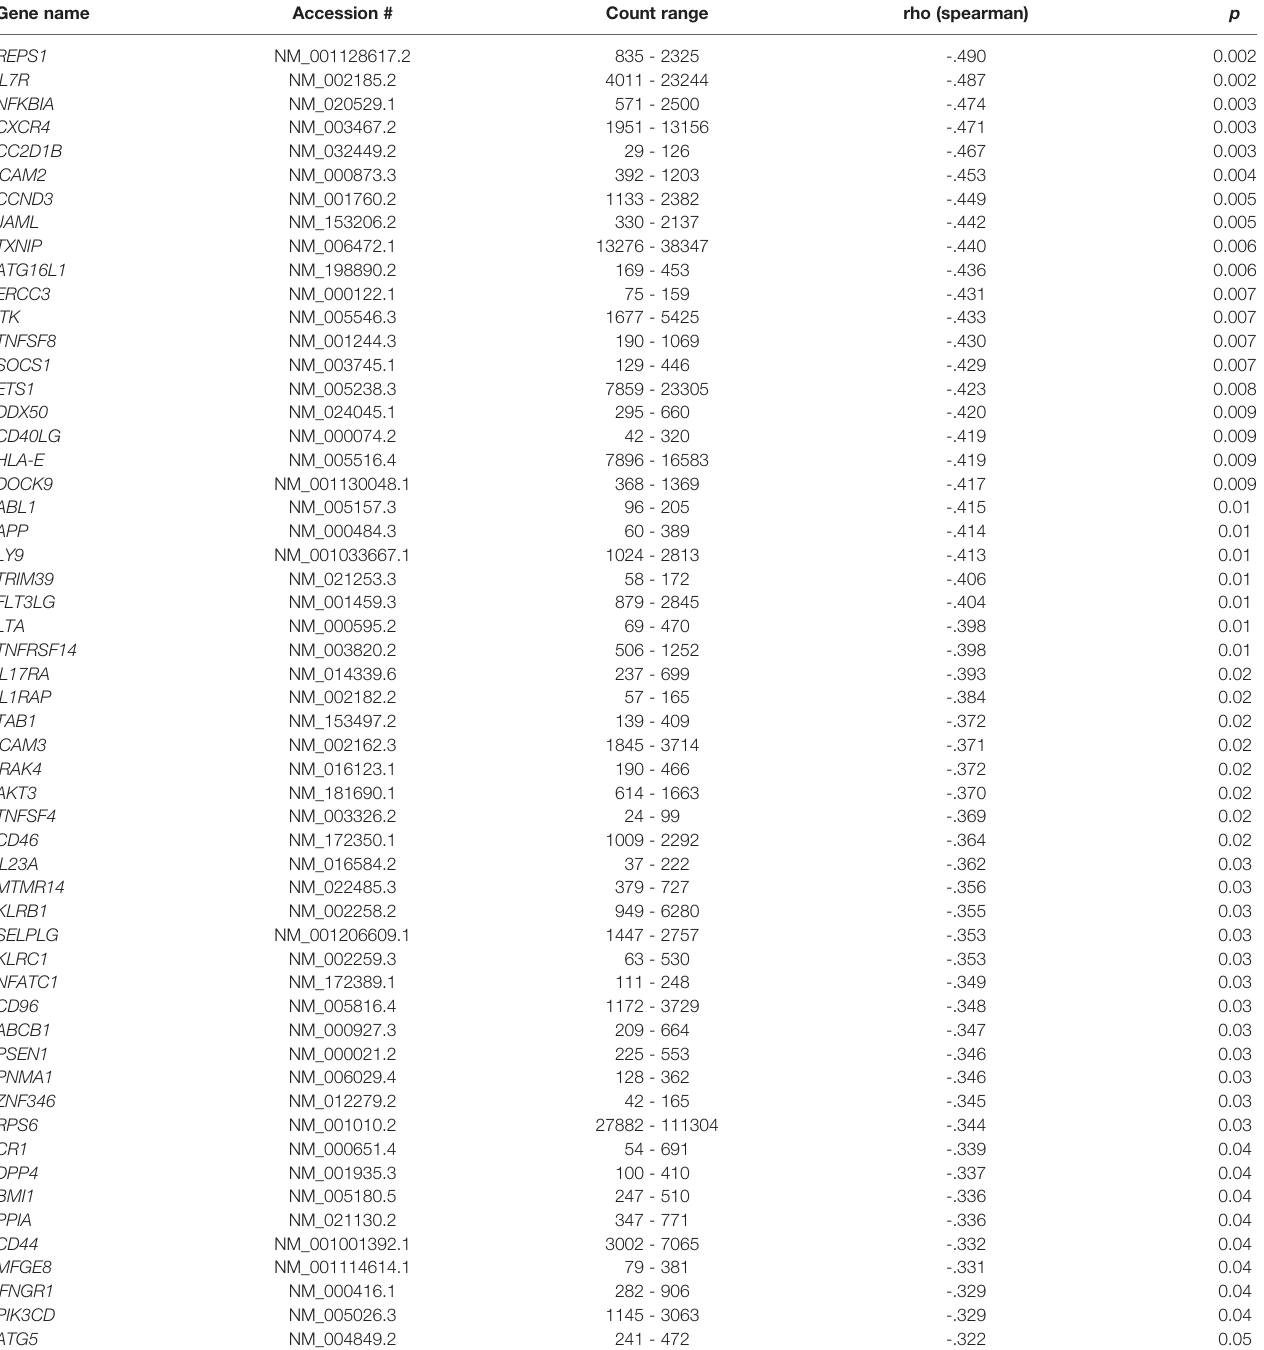
TABLE 1 | The 55 genes in isolated CD8 + T cells from healthy subjects (N = 38) with a negative correlation of gene expression with sIL-2R a